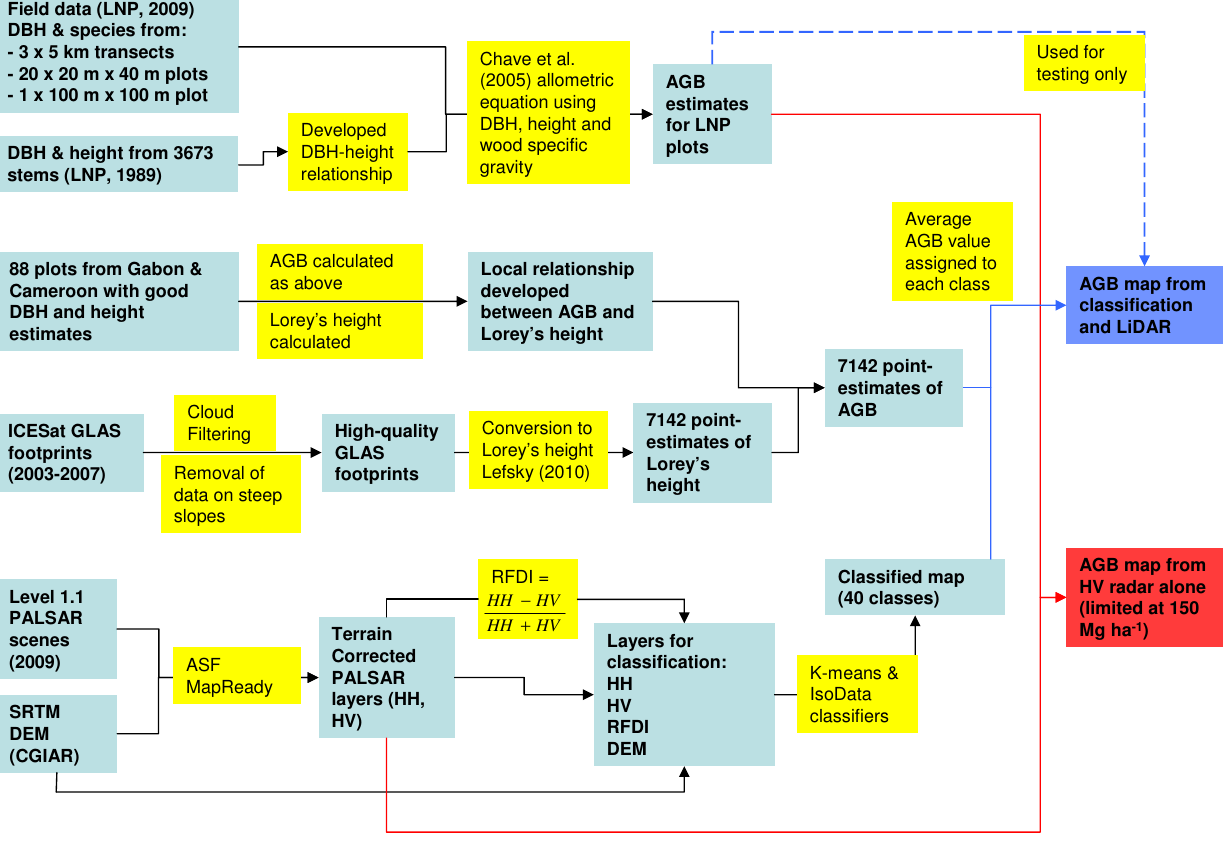
Fig. 2. Diagram showing the processing chain for the production of the biomass maps from the input datasets. AGB=Aboveground Biomass; ASF=Alaska Satellite Facility; CGIAR=Consultative Group on International Agricultural Research; DBH=Diameter at Breast Height (1.3m); DEM=Digital Elevation Model; ICESat-GLAS=Ice Cloud and land Elevation Satellite – Geoscience Laser Altimeter System; LNP=Lop´e National Park; PALSAR=Phased-Array L-band Synthetic Aperture Radar; RFDI=Radar Forest Degradation Index; SRTM=Shuttle Radar Topography